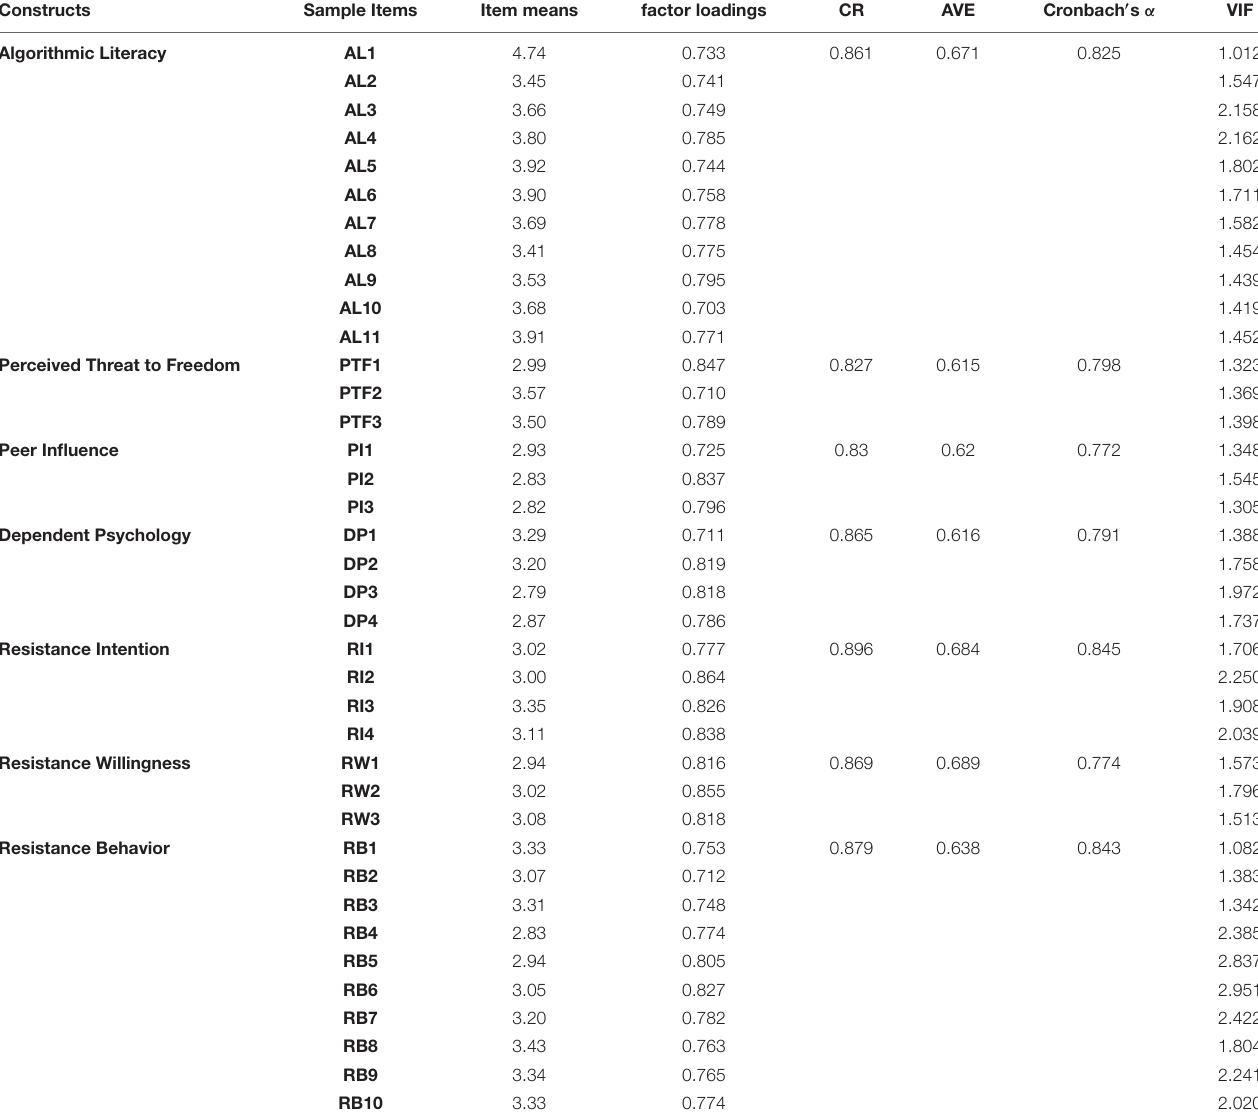
TABLE 2 | Sample items, means, Cronbach (cid:48) s alpha scores, factor loadings, CR, AVE for each construct. Constructs Sample Items Item